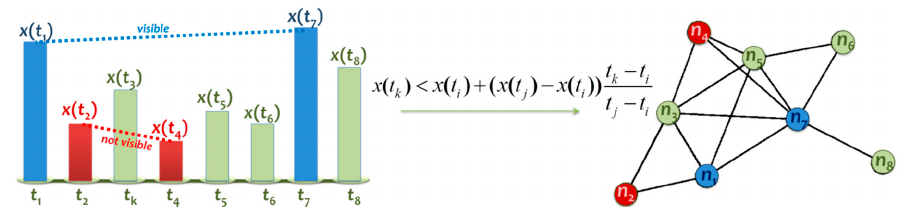
Figure 2. ( left ) Example visible and not visible pairs of nodes according to the natural visibility algorithm (NVG); ( right ) the visibility graph generated from the time-series shown at the left side. In geometric terms, a visibility line can be drawn between two time-series’ nodes n i , n j ∈ V whether no other intermediating node n k ≡ ( t k , x ( t k )) obstructs their visibility [23,24], namely, no other intermediary node is so high as to intersect the visibility line created by this pair of nodes (Figure 2). Therefore, two time-series’ nodes can enjoy a connection in the associated visibility graph if they are visible through a visibility line [23]. The visibility algorithm conceptualizes the time-series as a landscape and produces a visibility graph associated with this landscape [24]. The associated (to the applied [23,24].